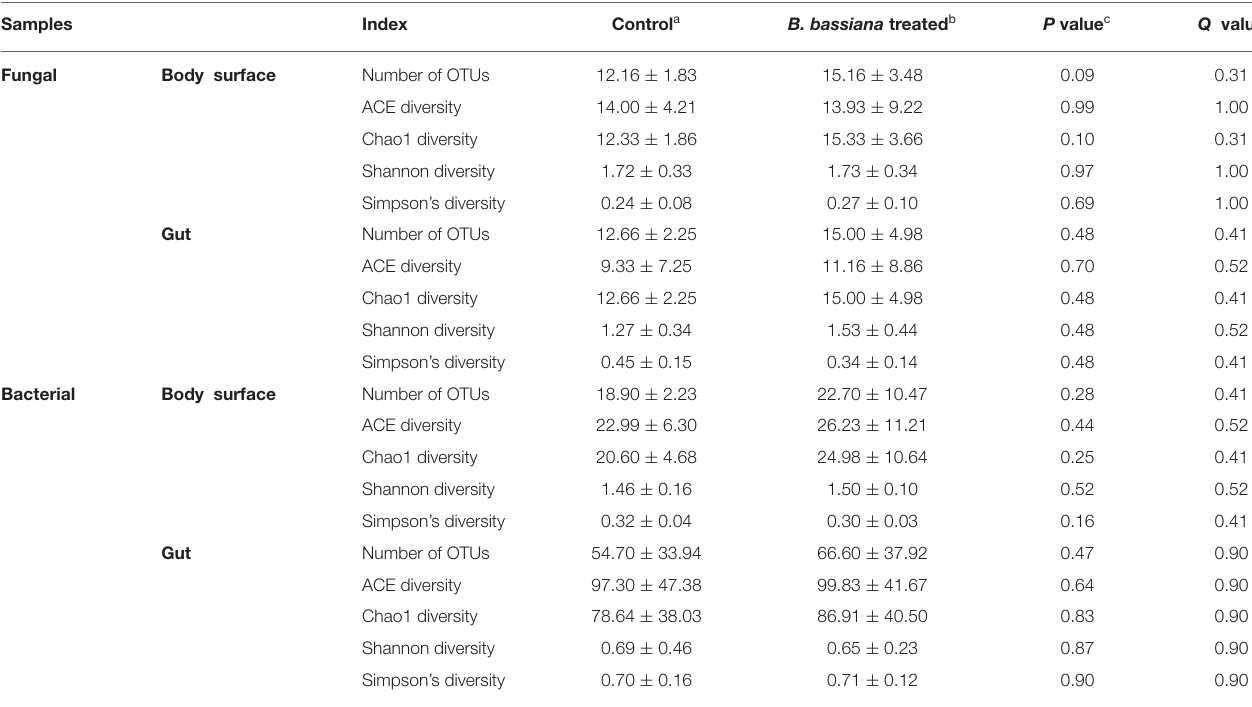
TABLE 1 | Diversity indices of fungal and bacterial community from body surface and gut samples of D. antiqua larvae.